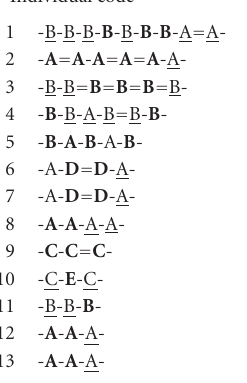
Figure 1: Consecutive visits to flowers by marked Ceratina flavipes in late June 2000 at the study quadrat. Ishikari study site. Each alphabet indicate flowering species, A: Rosa rugosa ; B: Rosa parvifolius ; C: Picris hieracioides v. glabrescens ; D: Lathyrus japonicus ; E: Calystegia soldanella . And each marks indicated the behaviors, = : Moving within same stem; -: Moving to another stem. Bord face letter indicates collection of pollen, underline indicates staying at central of flower witout collecting pollen, and standard face letter indicates landing on the flower